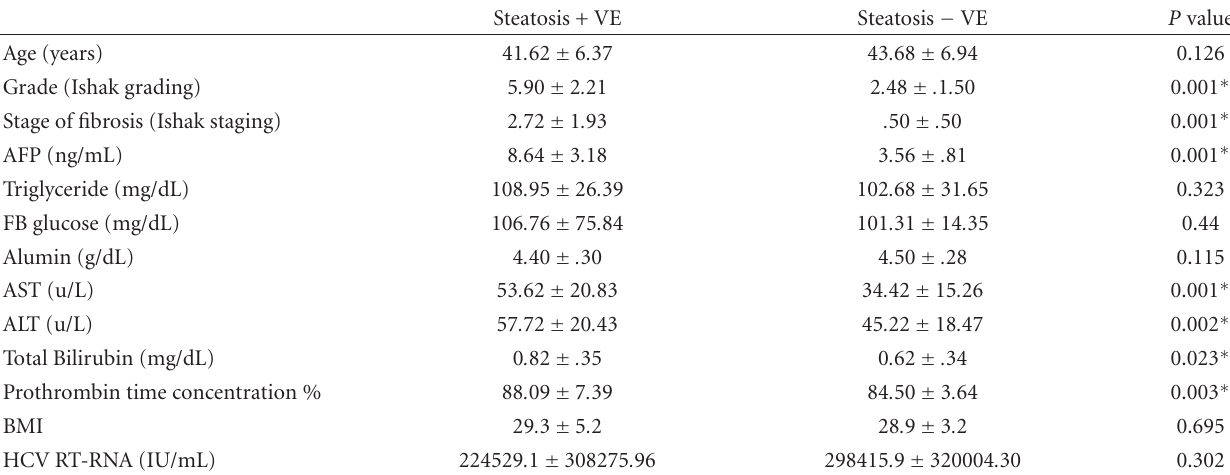
Table 1: Clinical, biochemical and histopathological characteristics of patients with and without steatosis.